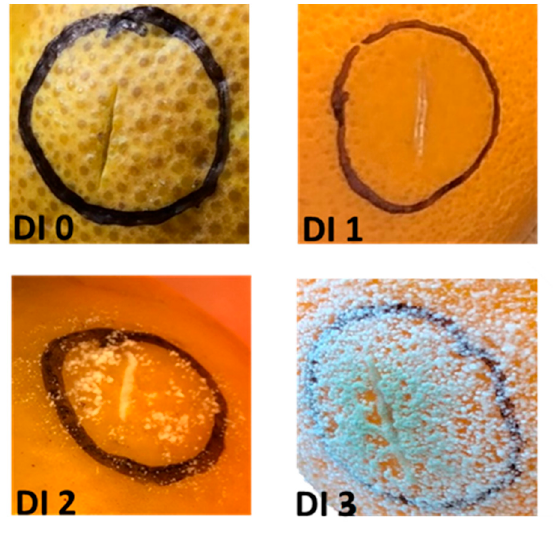
Figure 1. Fruit appearance five days post-inoculation and evaluation of disease index (DI): DI 0 = no symptoms; DI 1 = presence of rot; DI 2 = presence of mycelium; DI 3 = presence of spores.